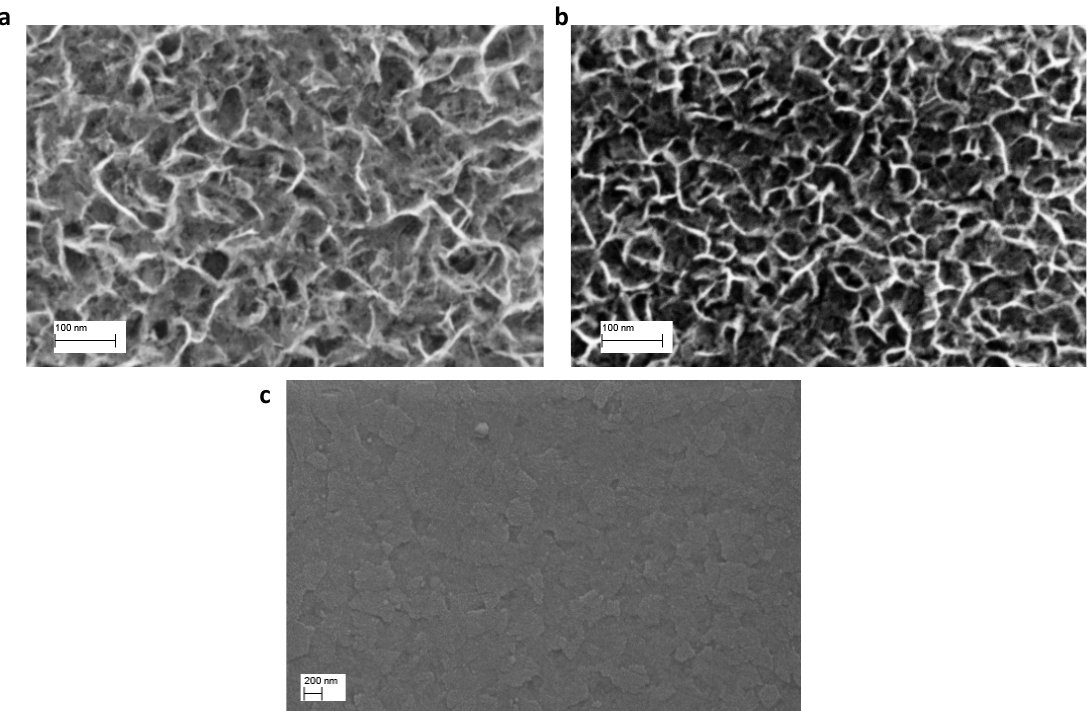
Figure 1. ( a ) Top view SEM micrograph of NiO deposited at 1.00 V vs. Ag/AgCl. ( b ) Top view SEM micrograph of NiO deposited at 1.10 V vs. Ag/AgCl. ( c ) Top view SEM micrograph of NiO deposited by sol-gel.